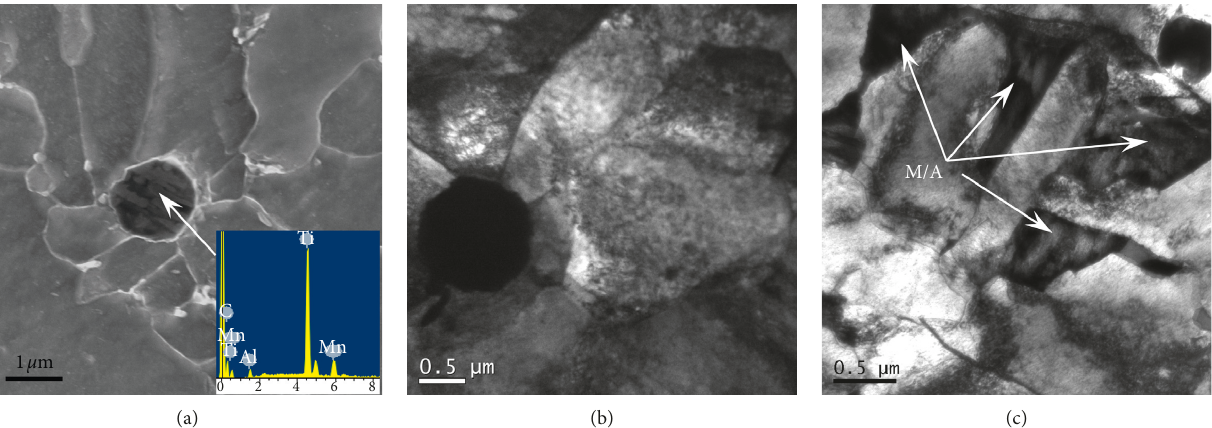
Figure 4: Acicular ferrite nucleated surrounding the nonmetallic oxide inclusion and M/A constituents in the microstructure: (a) SEM; (b) TEM; (c) M/A constituents.